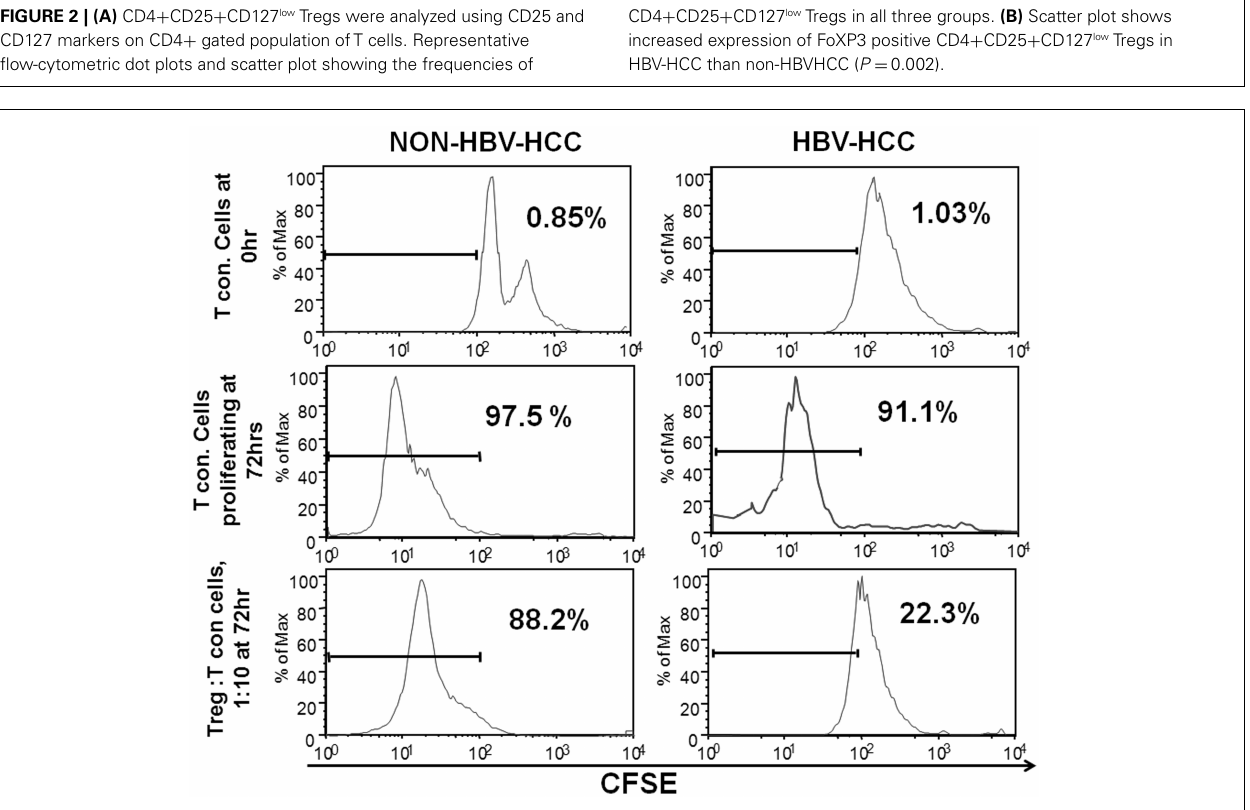
to assess CFSE dilution.Tregs from HBV-HCC showed significantly high suppression ofTcon after 72h of co-culture (right panel) as compared toTregs from non-HBV-HCC.